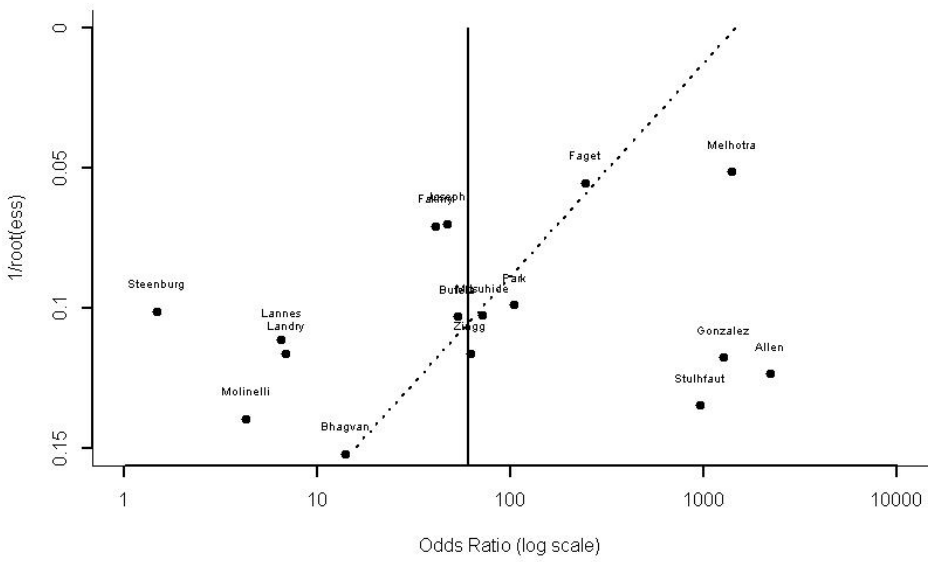
Figure 4. Deek’s asymmetry funnel plot for the assessment of publication bias. The bivariate model jointly synthesizes the sensitivity and specificity to give summary estimates, which are represented as the summary point on an SROC plot. Confidence and prediction regions plotted around the summary point enable joint inferences to be